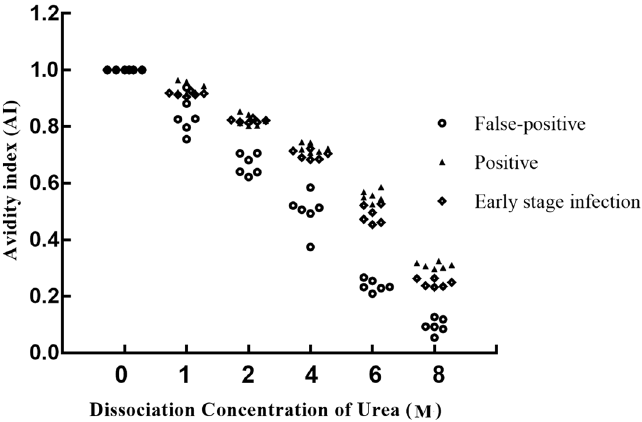
Figure 4. Urea dissociation test to determine the appropriate dissociation concentration.